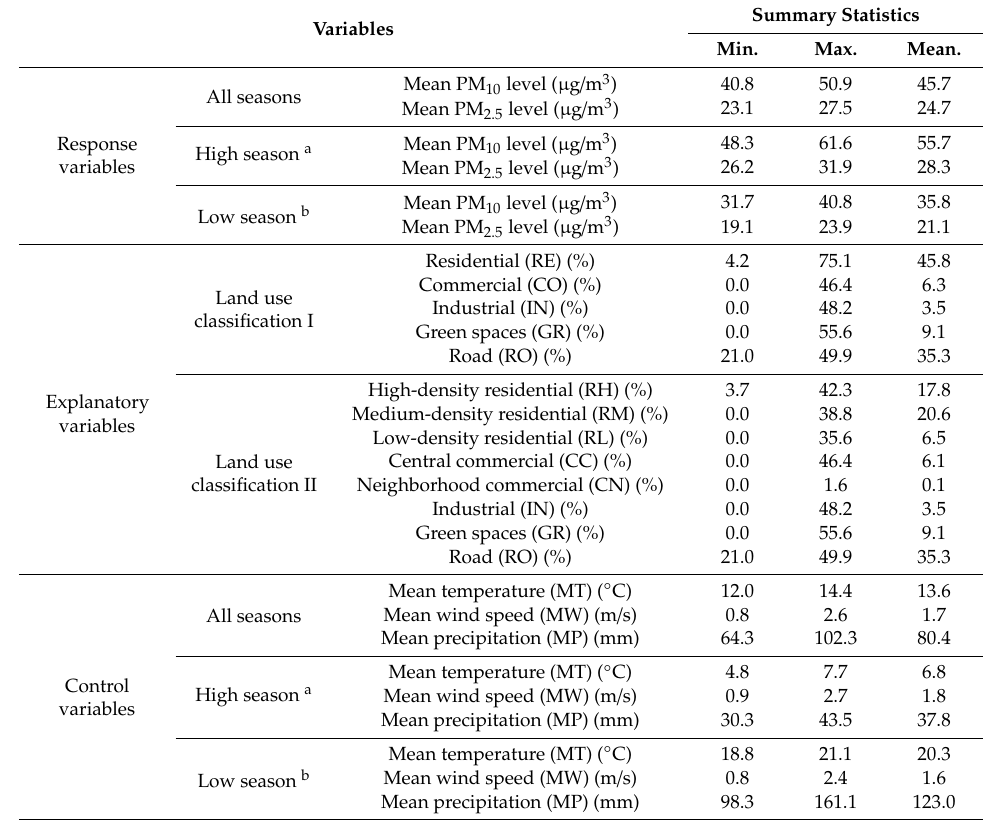
Table 2. Summary statistics for the 25 district monitoring stations and their surrounding land use